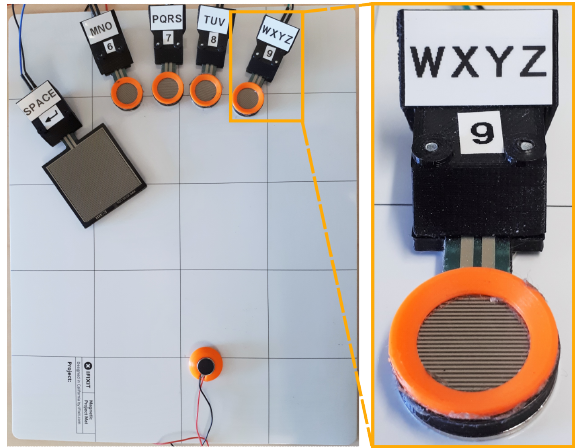
Figure 7. Magnetic pad and the buttons for the right hand as well as coin-shaped, eccentric, rotating mass vibration motors (MF-6318927) for haptic feedback, with a diameter of 10 mm and a height of 2.7 mm. On the right, a detailed view of a single button with a naming indicator and a support ring to prevent the finger from slipping off the